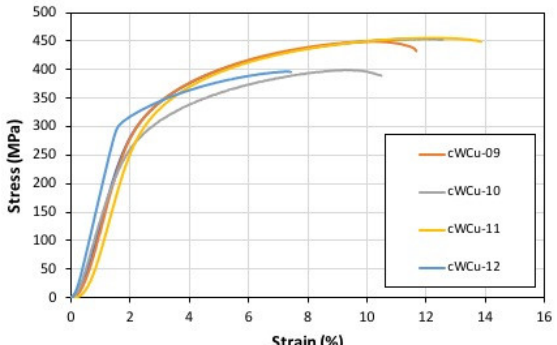
Figure 3. The experimental results of cW-Cu specimens in accordance with ASTM E9.